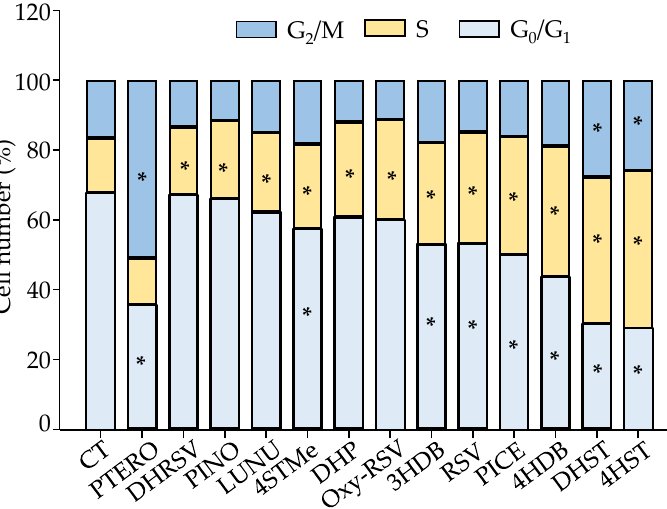
Figure 9. Cell cycle distribution in Caco-2 cells after 72 h. IC 50 concentrations (Table 1) were assayed for each compound. Data are shown as the mean ± SD of 3 independent experiments. * p < 0.05 vs. control (CT).